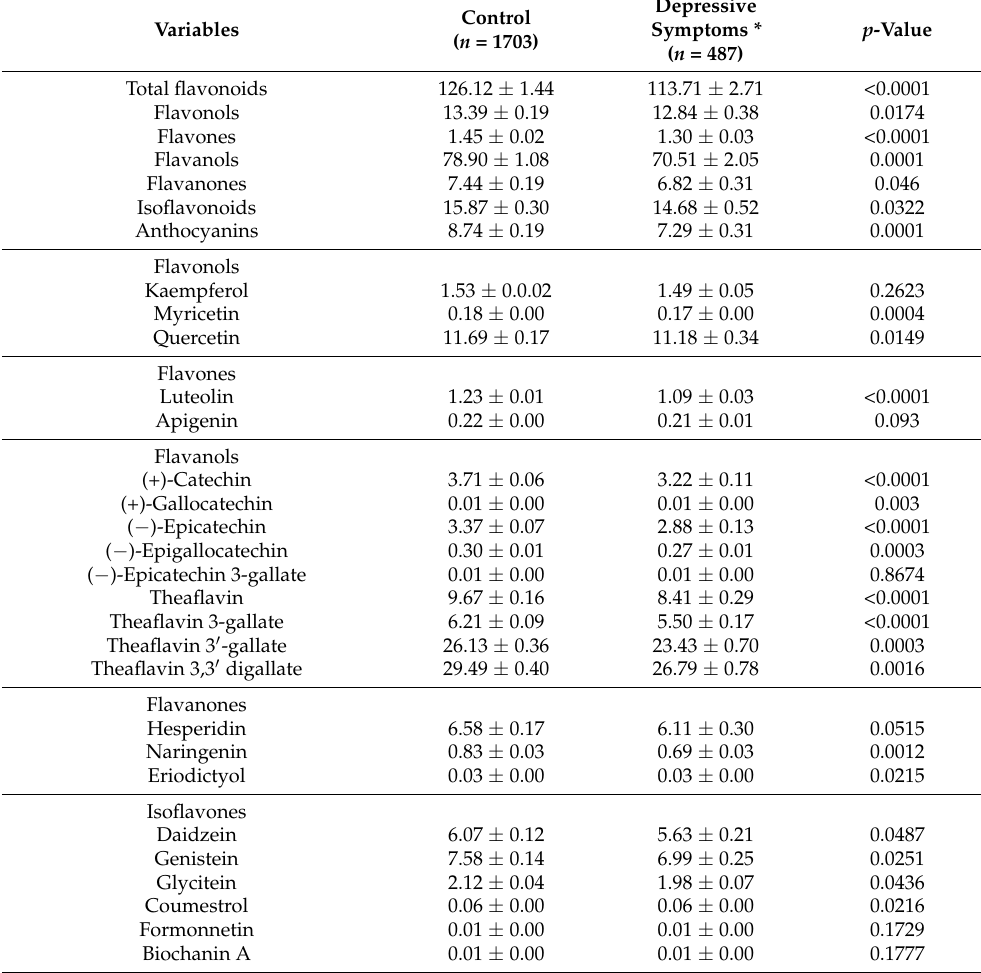
Table 2. Intake of flavonoids and carotenoids between the control and depressive symptom